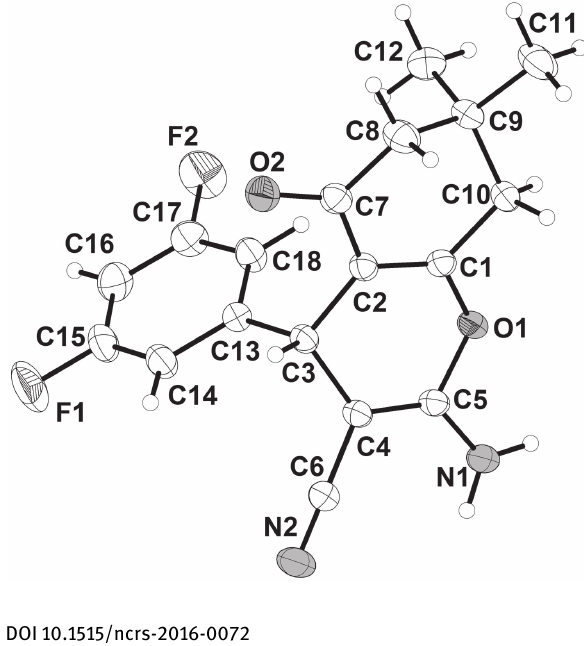
Table 1: Data collection and handling.